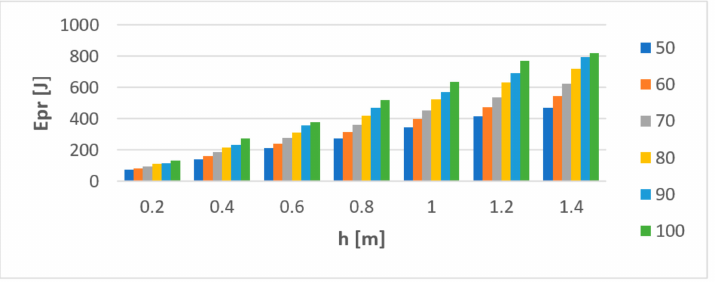
Figure 6. Impact energy E Pr of the hammer as a function of the impact height h, with the spherical impactor (for various masses in kg).